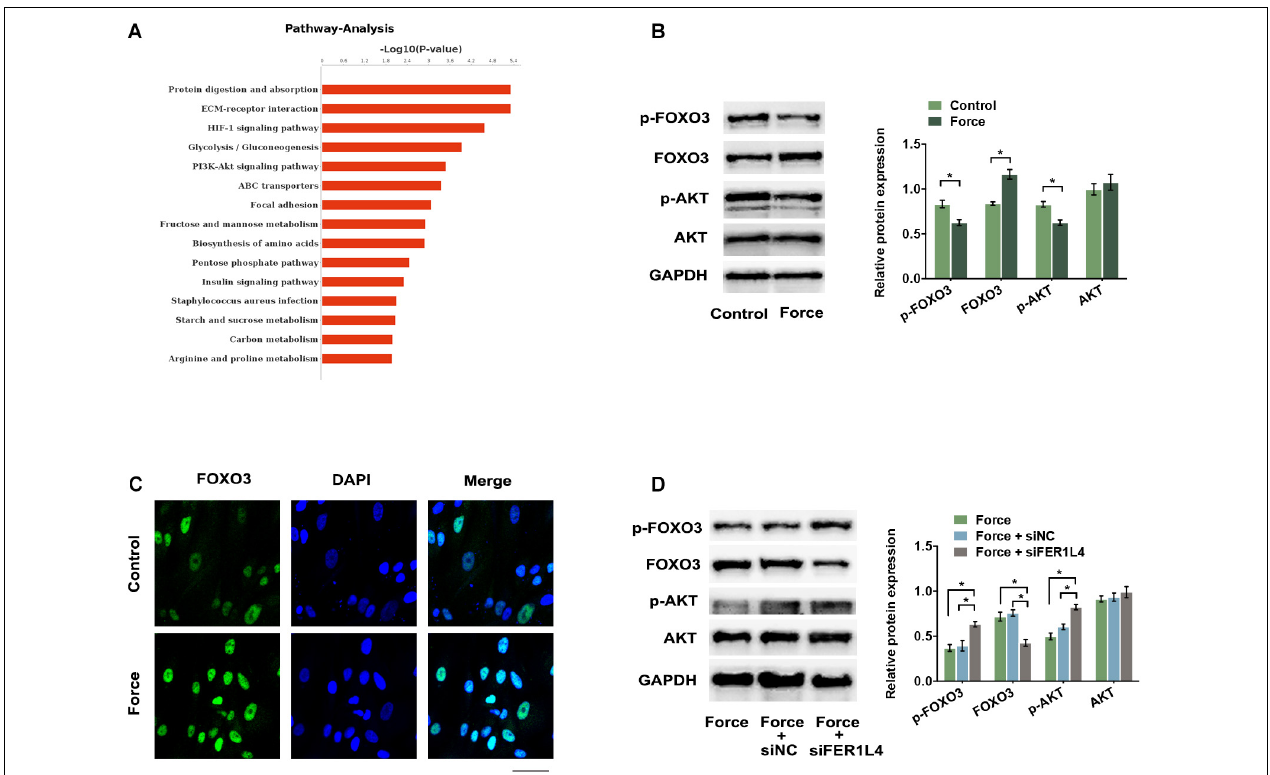
FIGURE 5 | Compressive force regulated AKT/FOXO3 pathway and FER1L4 partially mediated this process. (A) The top 15 enrichments in the KEGG pathway analysis of differentially expressed genes in PDLSCs under compressive force. PI3K/AKT signaling pathway was significantly affected. (B) Western blot analyses of p-AKT, AKT, p-FOXO3, and FOXO3 in the force and control group. Histograms show the quantification of the band intensities. (C) Images of FOXO3 immunofluorescence staining in PDLSCs under compression. Scale bar: 50 µ m. (D) Western blot analyses of p-AKT, AKT, p-FOXO3, and FOXO3 after the application of compressive force with or without FER1L4 knockdown. Histograms show the quantification of the band intensities. Data are presented as the mean ± SD ( n = 3, * p <